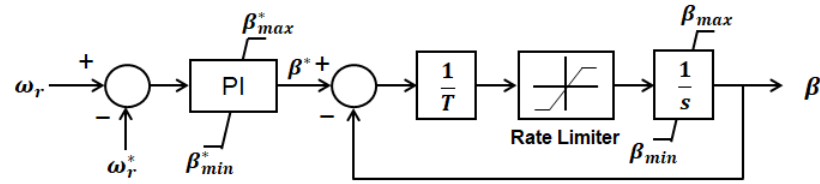
Figure 5. The pitch blade controller model.